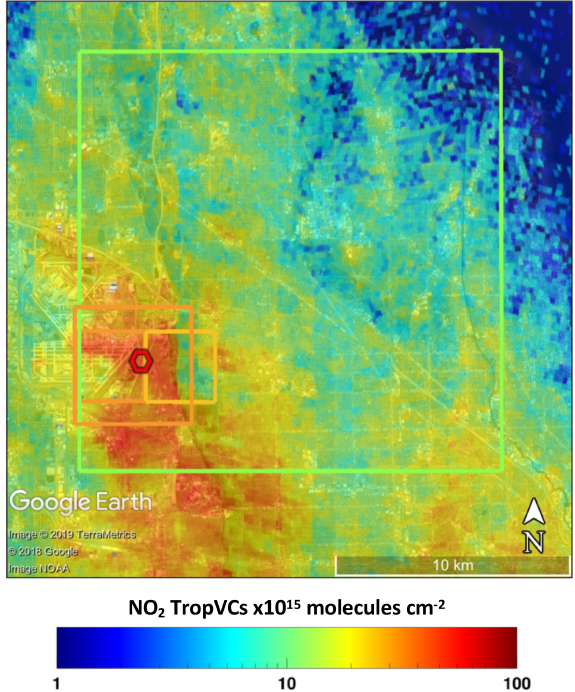
Figure 10. Map of GeoTASO TropVCs on a log 10 color scale at the 250m × 250m spatial resolution during the morning raster of 1 June 2017 over Schiller Park (same as Fig. 4) with the overlaid simulated pixels for TEMPO, TROPOMI, and OMI encompassing the Schiller Park ground site colored by the magnitude of their up- scaled TropVC. The hexagon indicates the location of the Pandora spectrometer and is colored by the observed Pandora NO 2 TropVC. Base map created in ©Google Earth